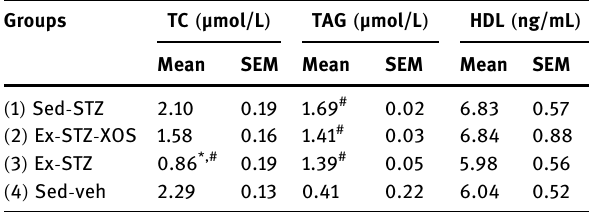
Table 1: Descriptive statistics of the parameters from the lipid pro fi le Groups